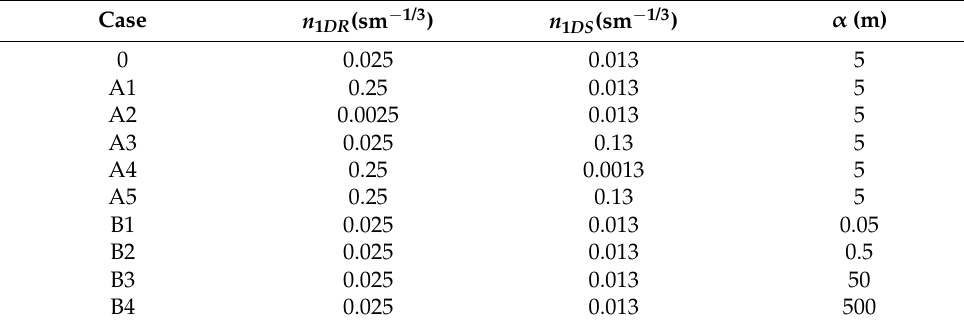
Table 1. Parameter settings of the sensitivity analysis of the urban flood model.